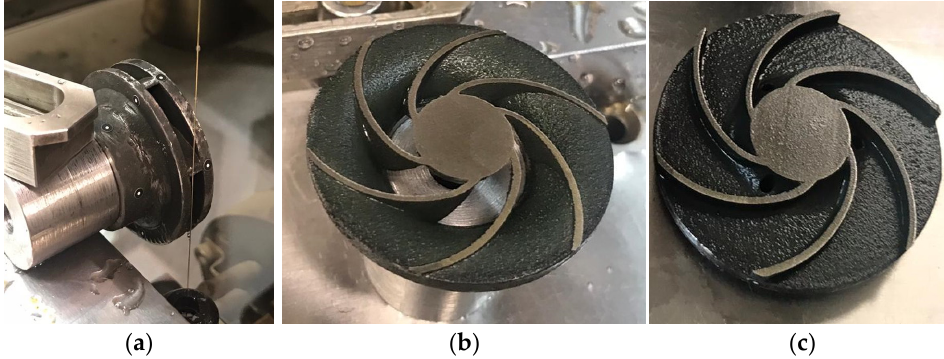
Figure 7. Electrical discharge machining (EDM) process of the closed impeller (45°): ( a ) EDM cutting process; ( b ) impeller shroud; ( c ) impeller disc.